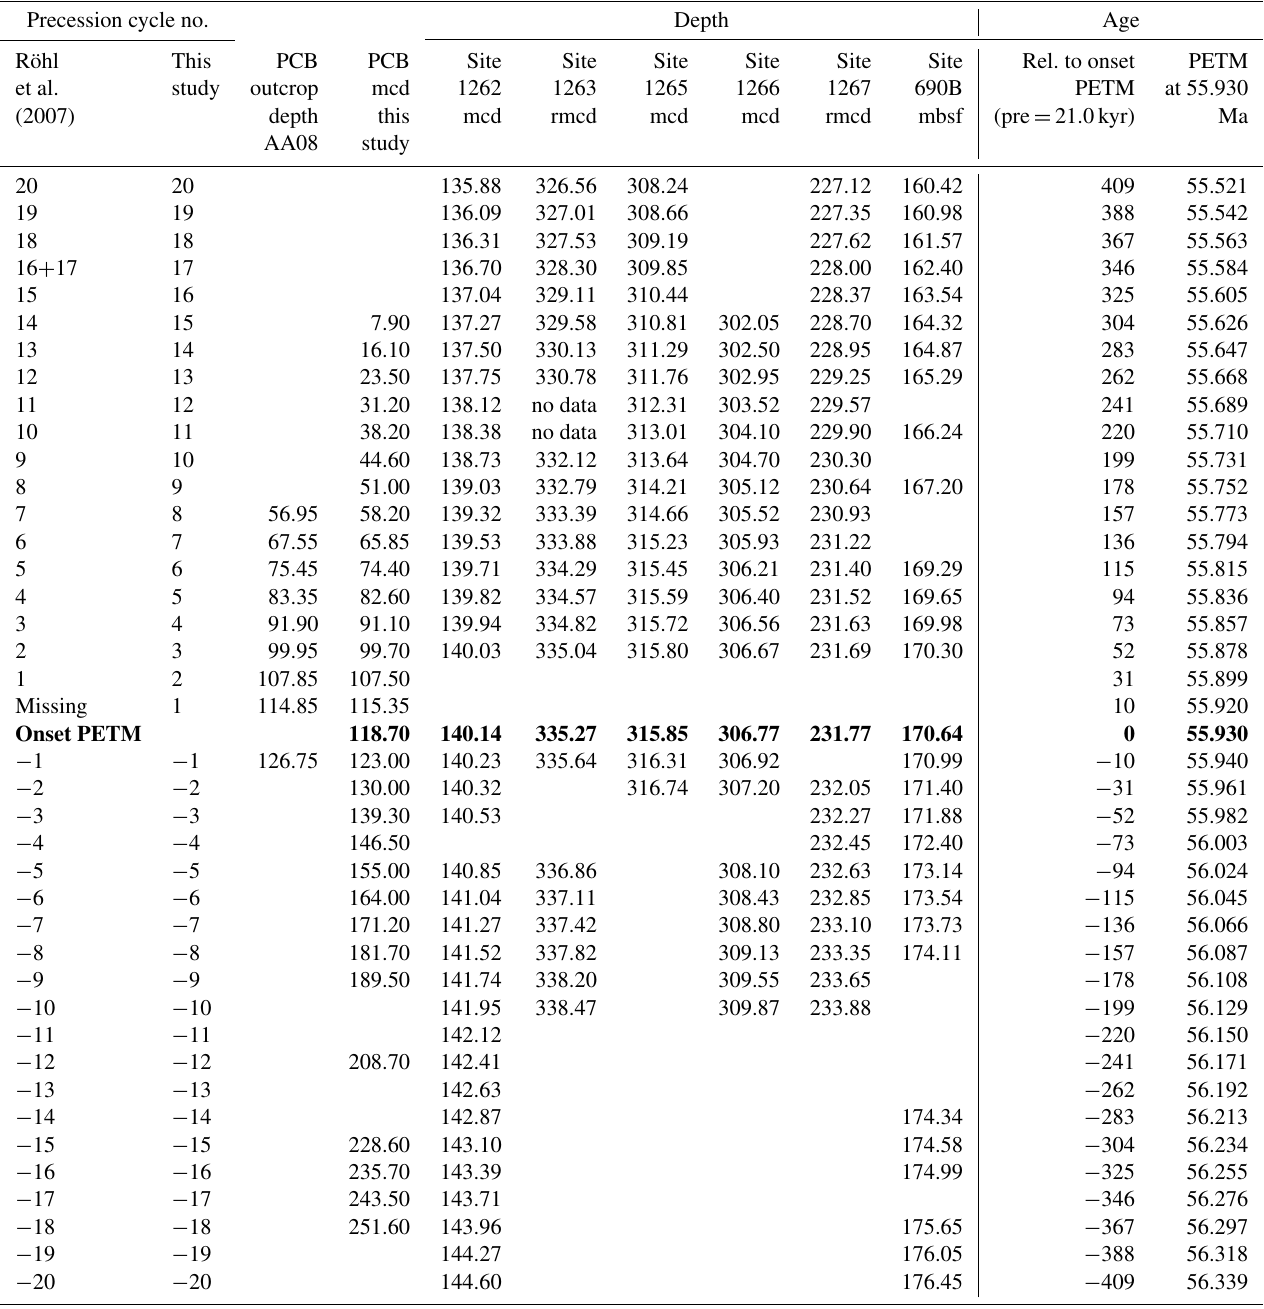
Table 1. PETM age model for Polecat Bench (PCB) and ODP Sites 690, 1262, 1263, 1265, 1266, and 1267. From left to right: precession cycle number of the extracted cycles as in Röhl et al. (2007) and this study, the equivalent depth in the Polecat Bench outcrop and the BBCP drill core, the respective depth of the assigned precession cycles at ODP sites, the relative age to the onset of the PETM assuming 21kyr duration for each precession cycle counted, and finally the absolute age using 55.930Ma as the age of the onset of the PETM as in Westerhold et al. (2007). Bold fond marks the onset of the PETM as identified in each drill core. Precession cycle